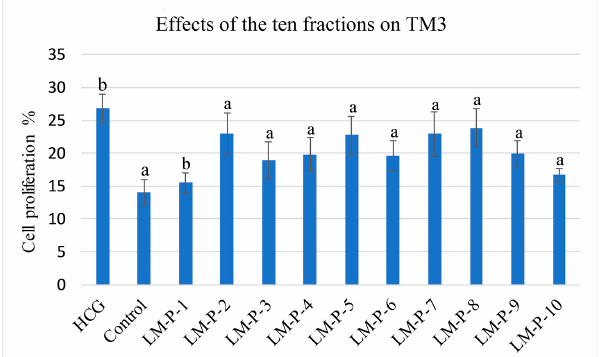
Figure 4. Effects of the ten fractions on TM3 (a p < 0.01, b p < 0.05). Figure 4. E ff ects of the ten fractions on TM3 (a p < 0.01, b p < 0.05).